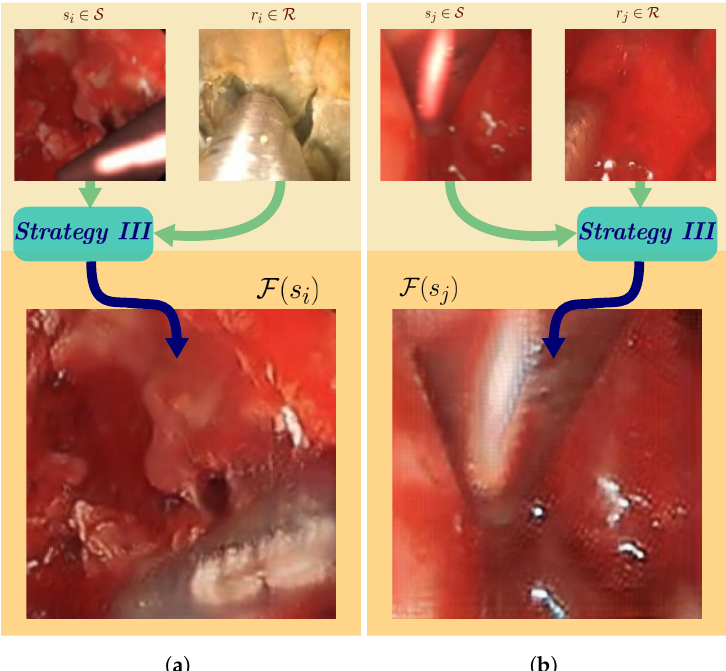
Figure 4. CycleGAN generated synthetic images from Strategy III : ( a ) Tool image style is adopted from the real image, background content is preserved resulting in realistic synthetic image; ( b ) tool border is retained even if s j and r j tool shapes